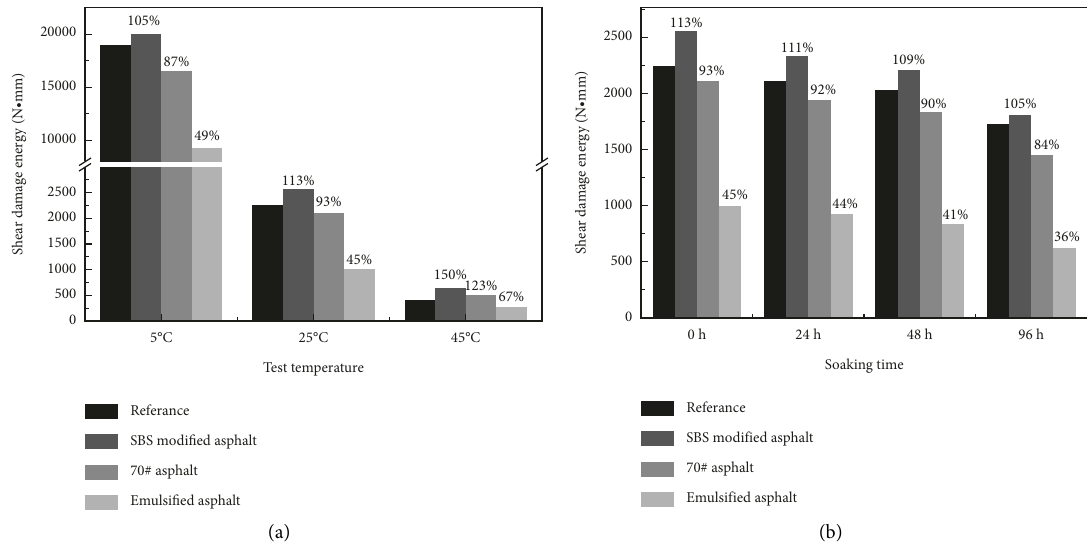
Figure 8: Comparison of the specimen shear damage energy under different test conditions. (a) Influence of service temperature; (b) influence of soaking